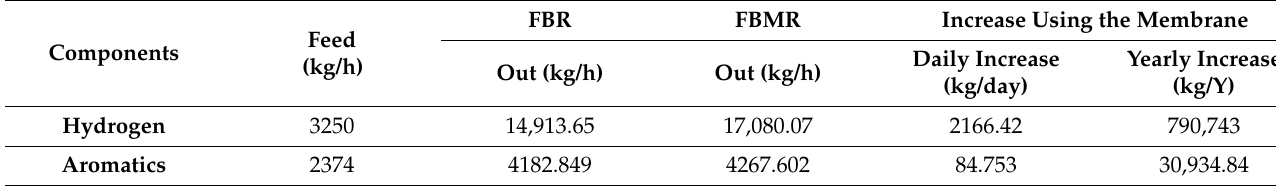
Table 5. The net increment in aromatics and